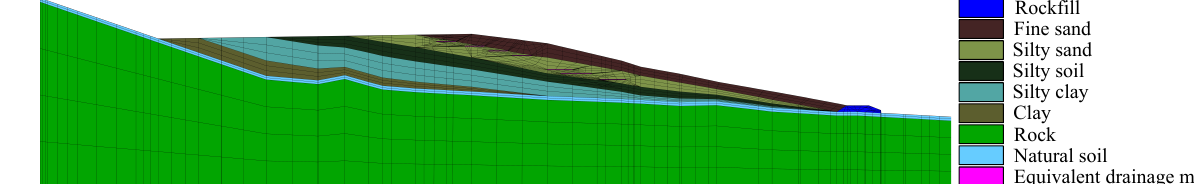
Figure 5. The typical section mesh of the quasi-3d model of tailings dam with the equivalent drainage structure to verify the suggested equivalent seepage analysis